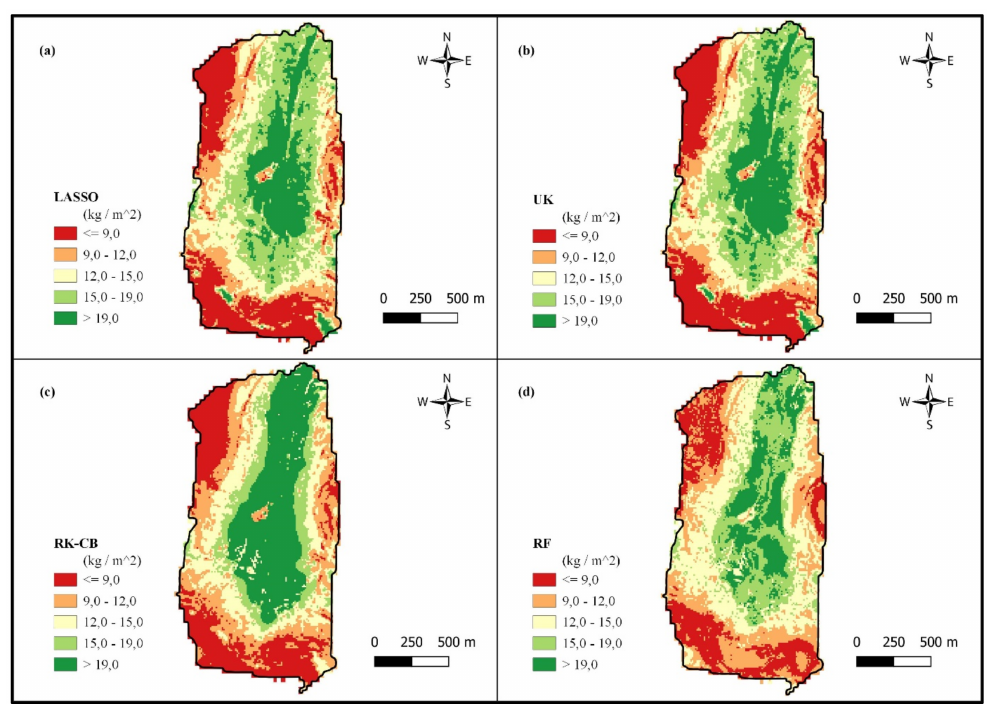
Figure 7. A comparison between the M3 catchment’s ( a ) LASSO, ( b ) UK, ( c ) RK-CB, and ( d ) RF, in order of their performance in regard to error (NRMSE).